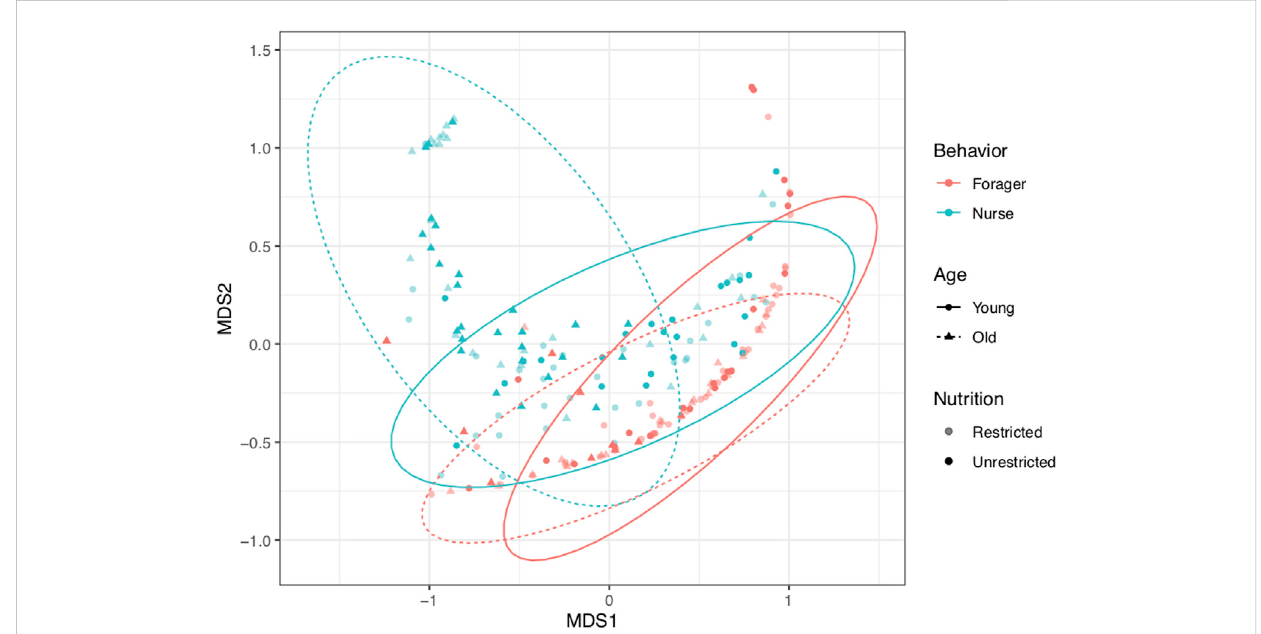
FIGURE 8 Multivariate ordination of samples based on non-metric multidimensional scaling (NMDS) of gene expression and virus levels. Behavior had the strongest effect on expression patterns (F 1, 197 = 55.13, p < 0.001, R 2 = 0.19). Age (F 1, 197 = 22.29, p < 0.001, R 2 = 0.076) and the interactions between age andbehavior(F 1,197 =8.75, p < 0.001, R 2 =0.030)andageandnutrition(F 1,197 =9.02, p < 0.001, R 2 =0.031)werealsosigni fi cant.Colorindicatesbehavior (red for foragers, blue for nurses).Shape and line typeindicate age (circles and solid lines for fi rst collection (2-week-old); triangles and dashedlines for second collection (3-week old). Shading indicates colony nutrition treatment (opaque for pollen-restricted ( “ R ” ), solid for unrestricted ( “ U ” ). Ellipses show 95% con fi dence limits for combinations of Behavior and